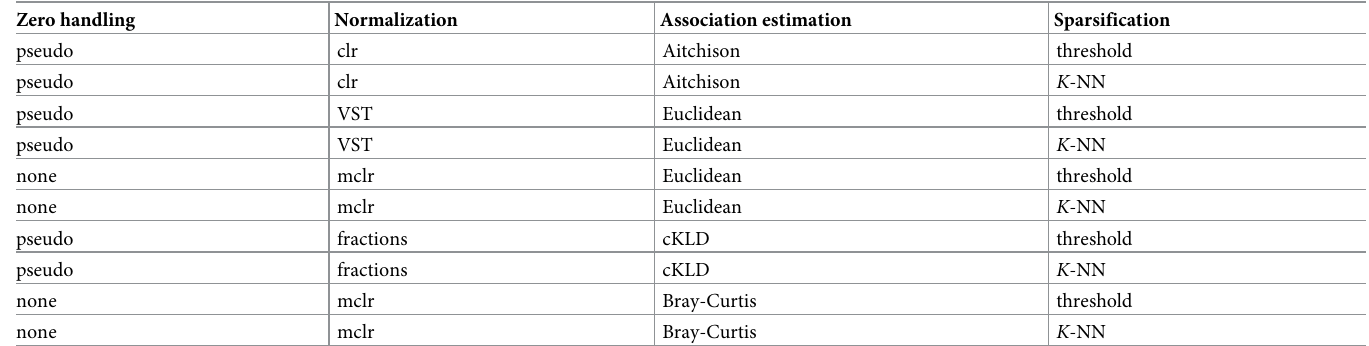
Table 8. Method combinations for generating weighted sample networks. The networks were used as input for fast greedy modularity optimization and Louvain com- munity